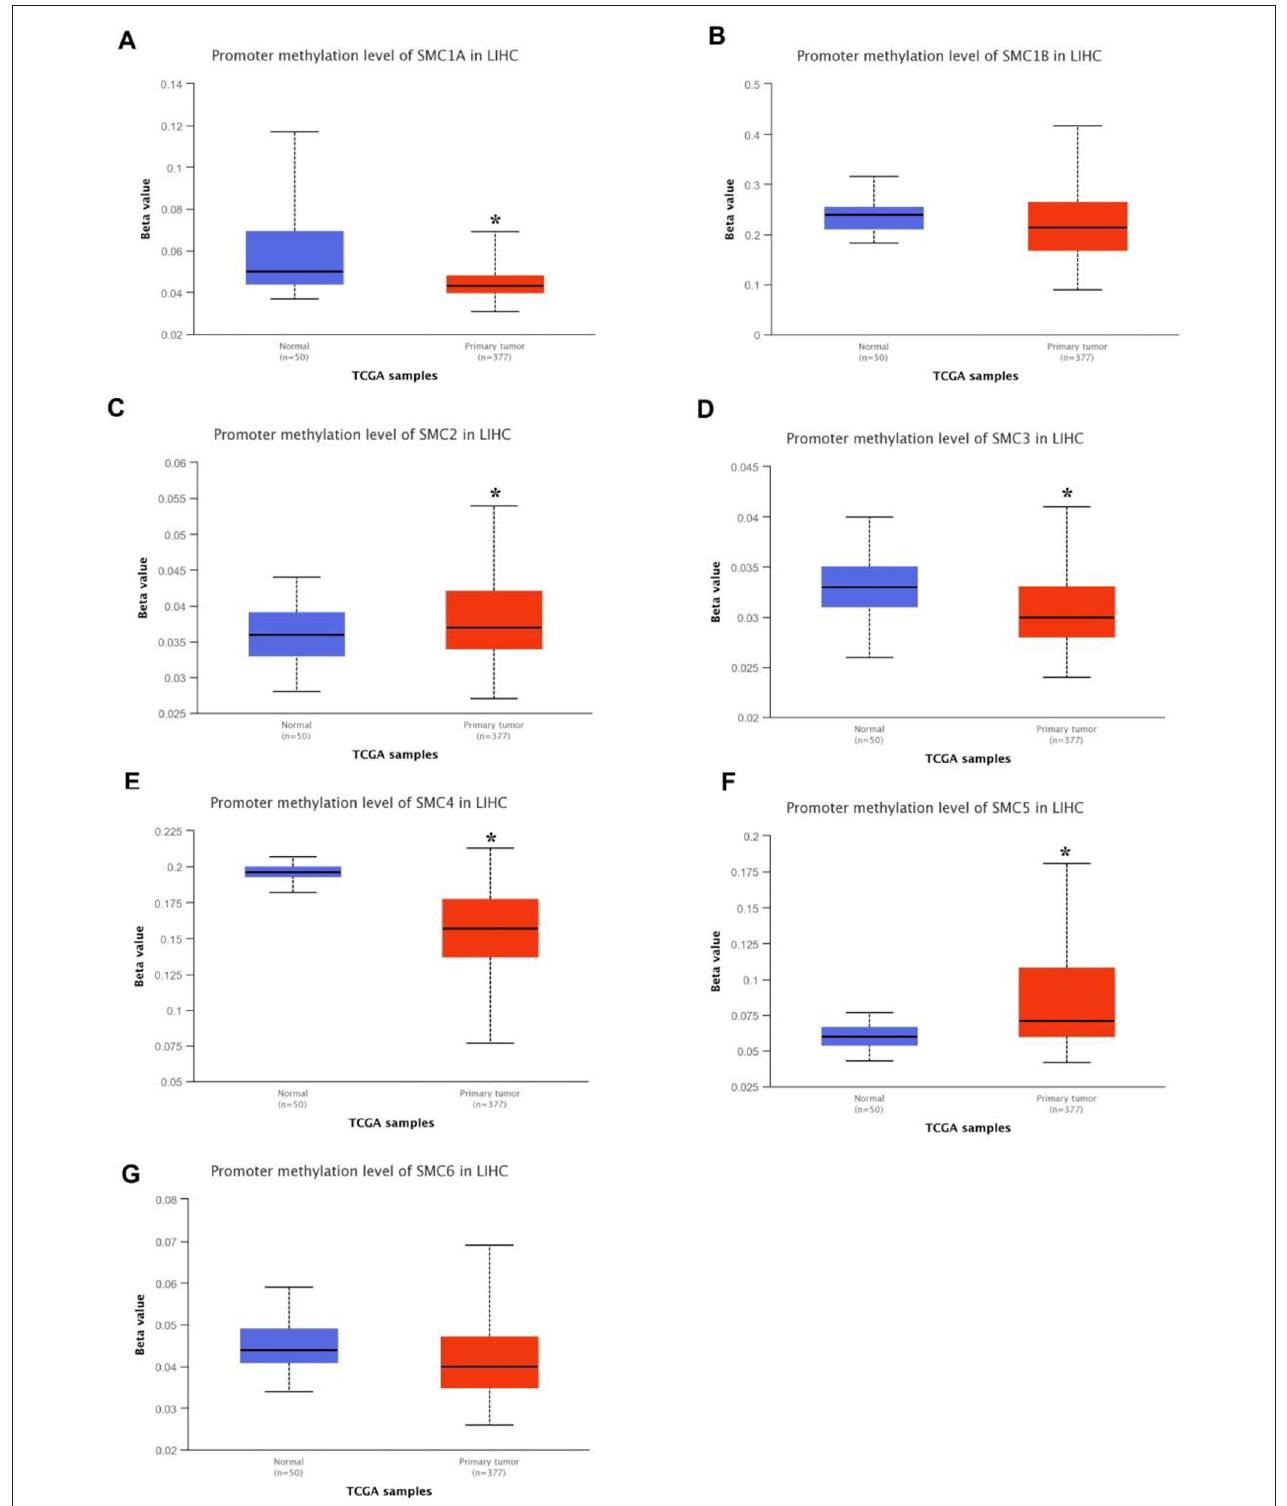
FIGURE 5 | DNA methylation levels of SMC family genes in HCC. (A-G) The DNA methylation change of SMC1A , SMC1B , SMC2 , SMC3 , SMC4 , SMC5 , and SMC6 in HCC by the UALCAN database. * P < 0.05 compared with control.